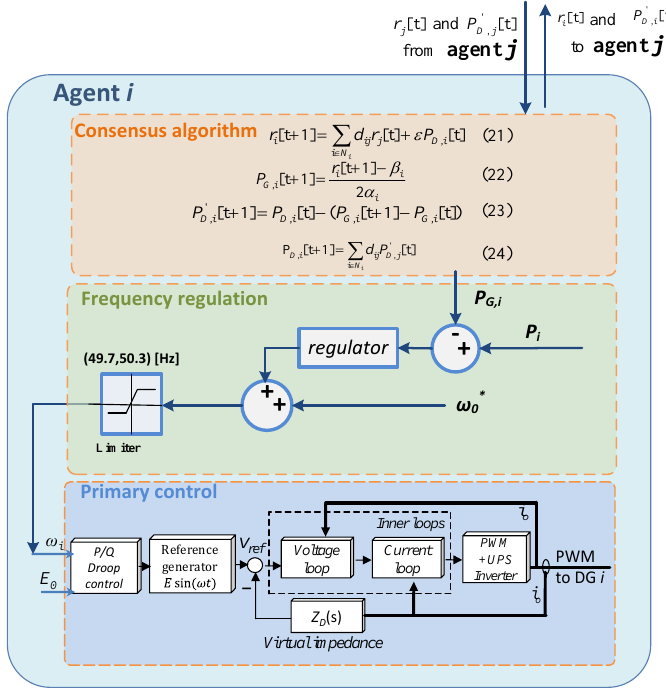
Figure 10. Control scheme of proposed control strategy for each agent.